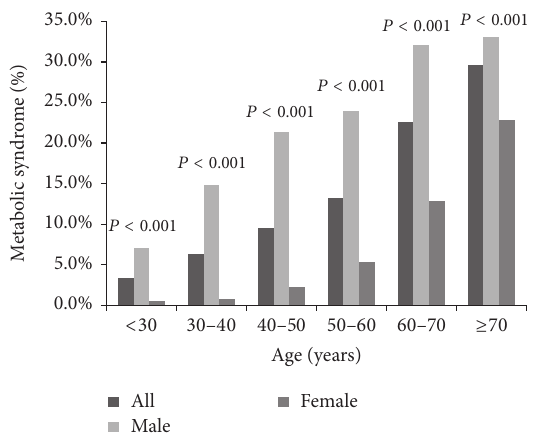
Figure 3: The prevalence of metabolic syndrome in subjects without sonographic fatty liver stratified by age and